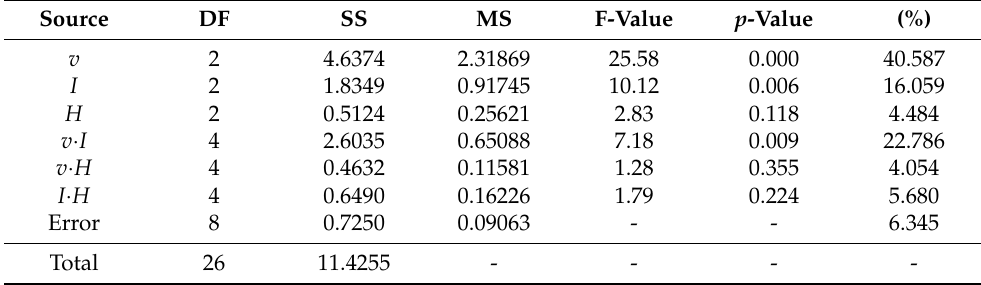
Figure 5. Experimental top kerf width vs. predicted top kerf width. Table 6. ANOVA for top kerf width.